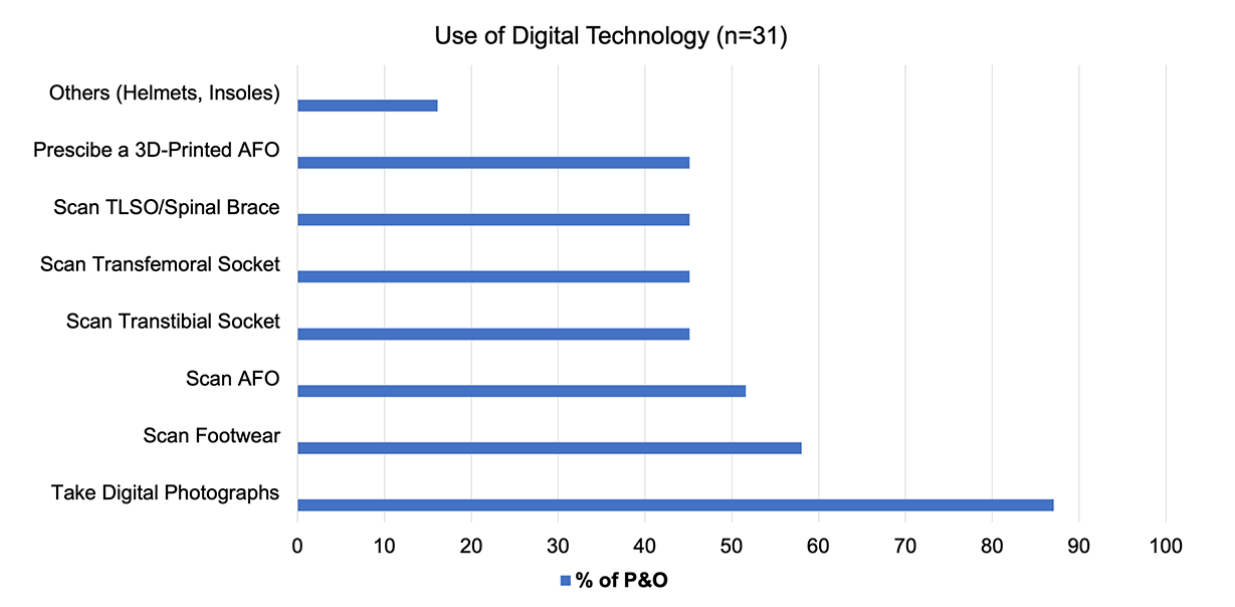
Figure 1. The applications of digital technology used in clinical practice. AFO: ankle-foot orthosis; P&O: prosthetic and orthotic; TLSO: thoracic-lumbar-sacral